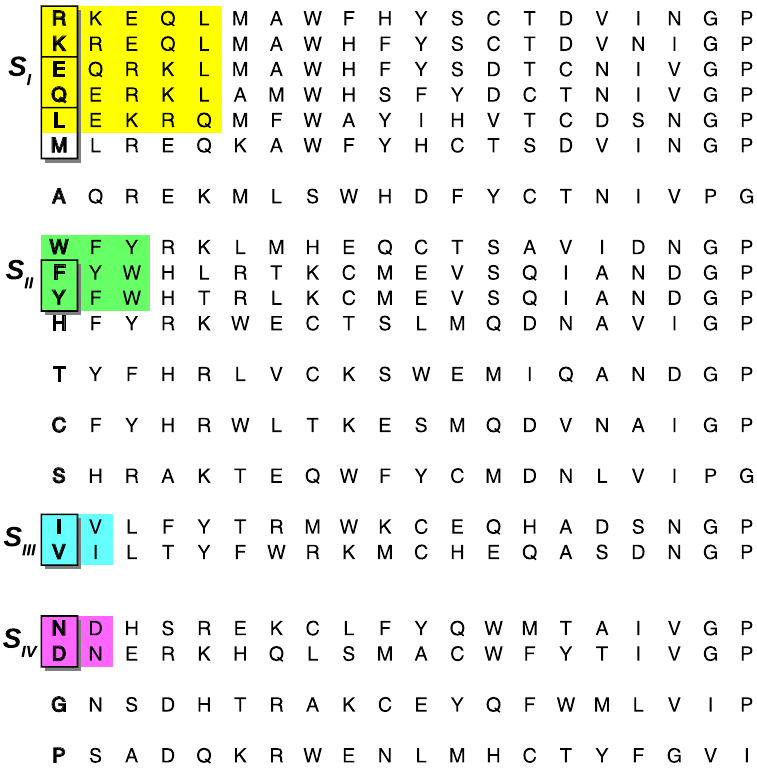
very high correlation ( R = 0.98) between mass and the electronic energy of amino acids—excluding the two sulfur-containing side chains 31 . In the present study, we found a complex relationship between the amino acids max ; this quan- mass M X and the structural trends via the probability at the most frequent conformational state, P X max corresponds to the tity is given by the highest peak of each Ramachandran distribution—max( P X ( φ , ψ )). P X most frequent conformation and, therefore, it is an indicator of structural persistence 32 . The α -helix conformation is the highest peak for all amino acids (but proline) with alanine at the top as the max (R = 0.05), we identified two main strongest helix former. While mass has an overall poor correlation with P X max : (a) > . P 0 200% max defines the set of strong helix and opposite trends delimited by separate ranges of P X X formers {Ala, Glu, Gln, Ile, Met, Leu, Lys, Arg, Val} (in descending order), with a negative correlation R = − 0.61; max defines the weak helix formers: {Trp, Asp, Phe, Tyr, Thr, His, Cys, Asn, Ser, Gly, Pro}, with and, (b) ≤ . P 0 200% X a positive correlation of R = 0.76. The small set of C- β branched amino acids ({Ile, Thr, Val}) plus proline shows a max . After excluding these four elements from the two main sets, their correlation of R = 0.78 between mass and P X respective correlations rise to R = − 0.87 for the strong helix formers, and to R = 0.87 for the set of weak helix max and the molecular mass indicates that formers. In strong helix formers, the negative correlation between P X light side chains have a better chance of forming an alpha helix than heavy ones. These three correlations reveal a direct involvement of the molecular mass on the α -helical propensities of the amino acids. A recent observation by Lehmann et. al . reports a negative correlation between the background frequency and codon degeneracy of amino acids with mass 33 . Seligmann already observed that the evolutionary rate of amino acid replacements correlates negatively with mass 34 . Accordingly, heavier amino acids are less frequent, which suggests that the genomes preserve a fundamental distribution ruled by simple energetics. Inverse correlations between the average amino acid biosynthetic cost and the levels of gene expression are consistent with natural